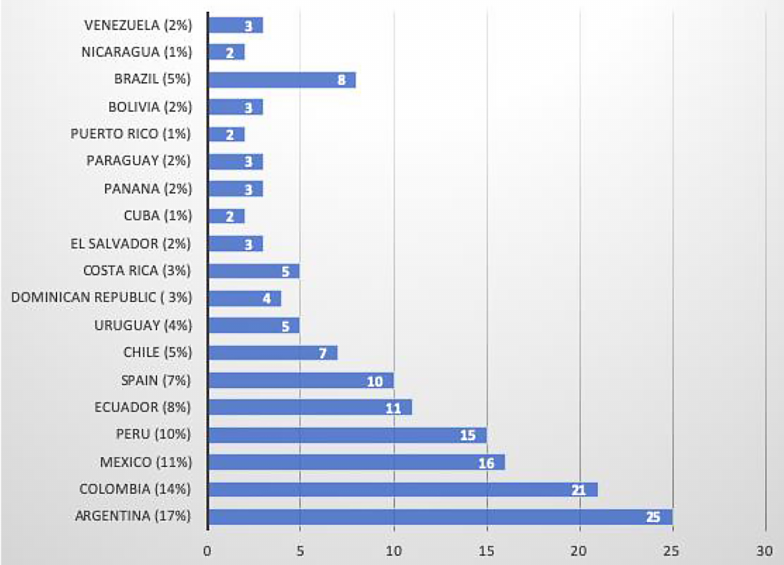
Figure 1 - Report of percentages of responses by